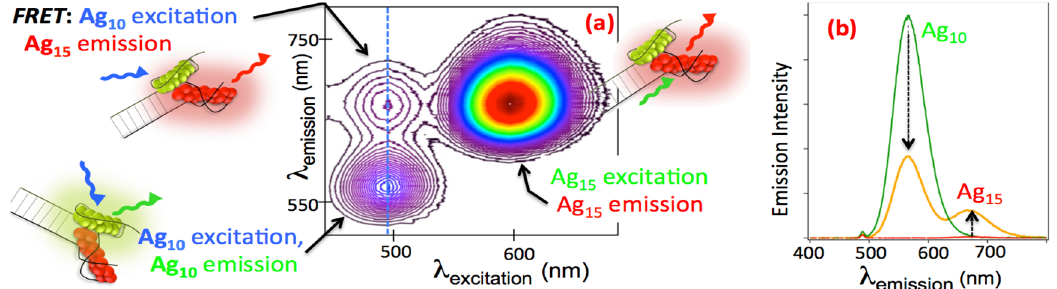
Figure 9. Development of dual cluster, bicolor silver cluster assemblies. Schematic to the left: Cartoons: paired cluster assemblies. Red: Ag 15 ; Green: Ag 10 . ( a ) Contour map of emission intensity from the purified solution of paired clusters shows the expected peaks for direct excitation of Ag 10 and Ag 15 , and FRET: emission from Ag 15 due to excitation of Ag 10 , via radiationless energy transfer [82]; ( b ) Emission excited at the Ag 10 absorbance peak. Green and (baseline) red curves are emission from separate solutions of the individual clusters. Orange: FRET of paired clusters produces emission from Ag 15 and reduces Ag 10 emission. The unshifted wavelengths relative to the individual clusters verify intact, stable assembly. (Adapted with permission from reference